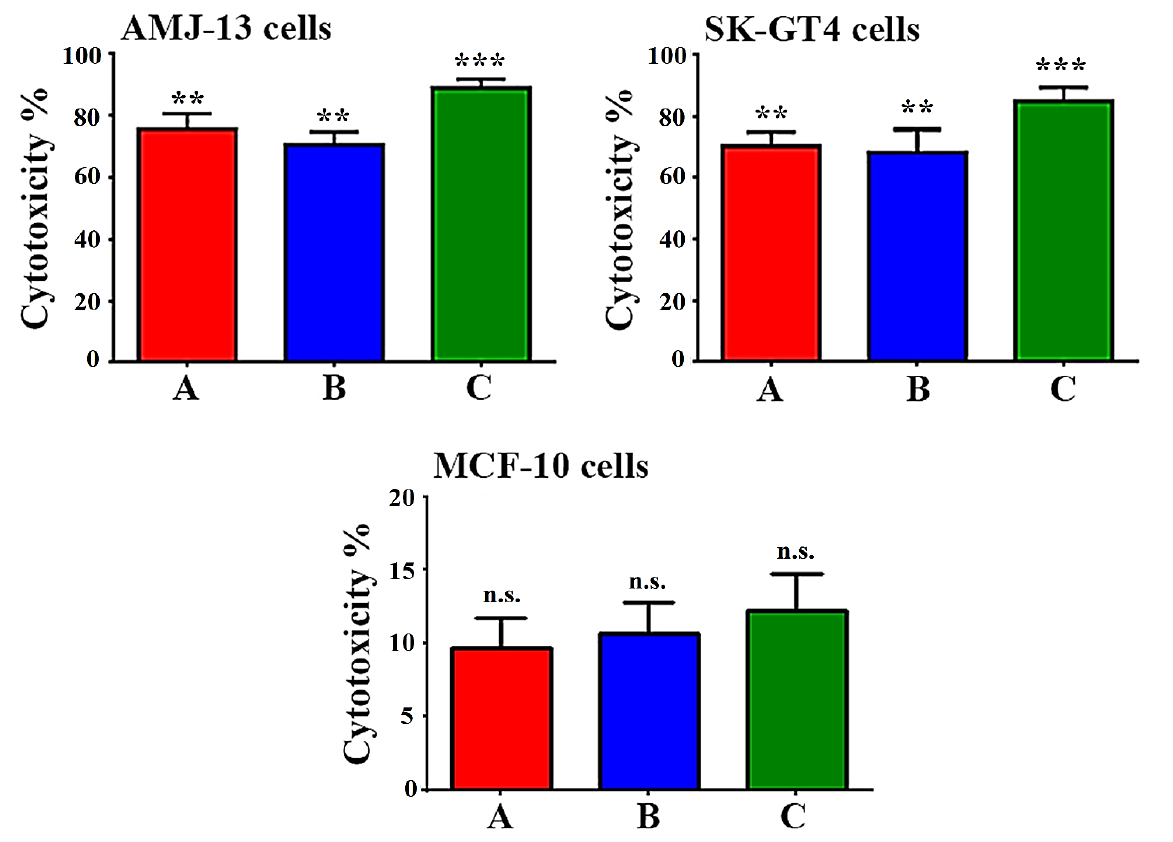
Figure 8. Cytotoxic effects of NPs against AMJ13, SK-GT4, and MCF-10 cell lines. (A) Au NPs, (B) ZnO NPs, and (C) Au/ZnO NCs. Data are represented as mean ± SD of triplicate. n.s.: non-significant ** p ≤ 0.01, *** p ≤ 0.001.